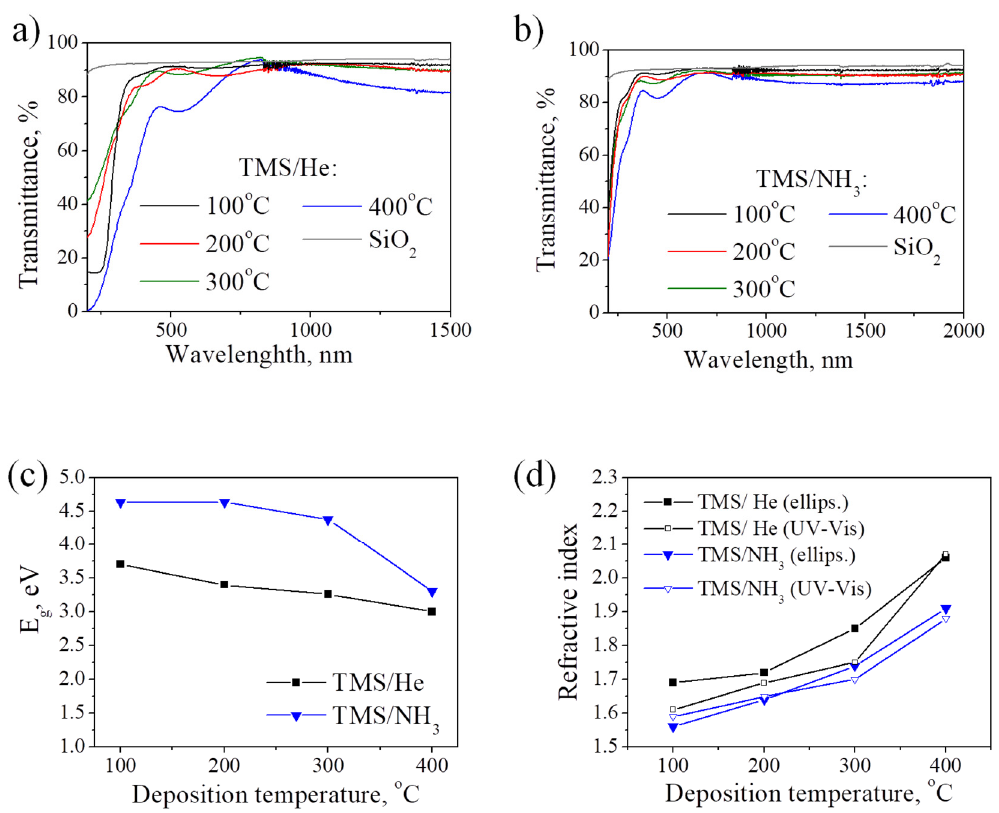
Figure 4. Optical properties of SiC:H (SiCN:H) films: evolution of transmittance of SiC:H/SiO 2 structures ( a ) and SiCN:H/SiO 2 structures ( b ), deposition temperature dependences of optical bandgap ( c ) and refractive index ( d ) obtained using UV-Vis and ellipsometry data.